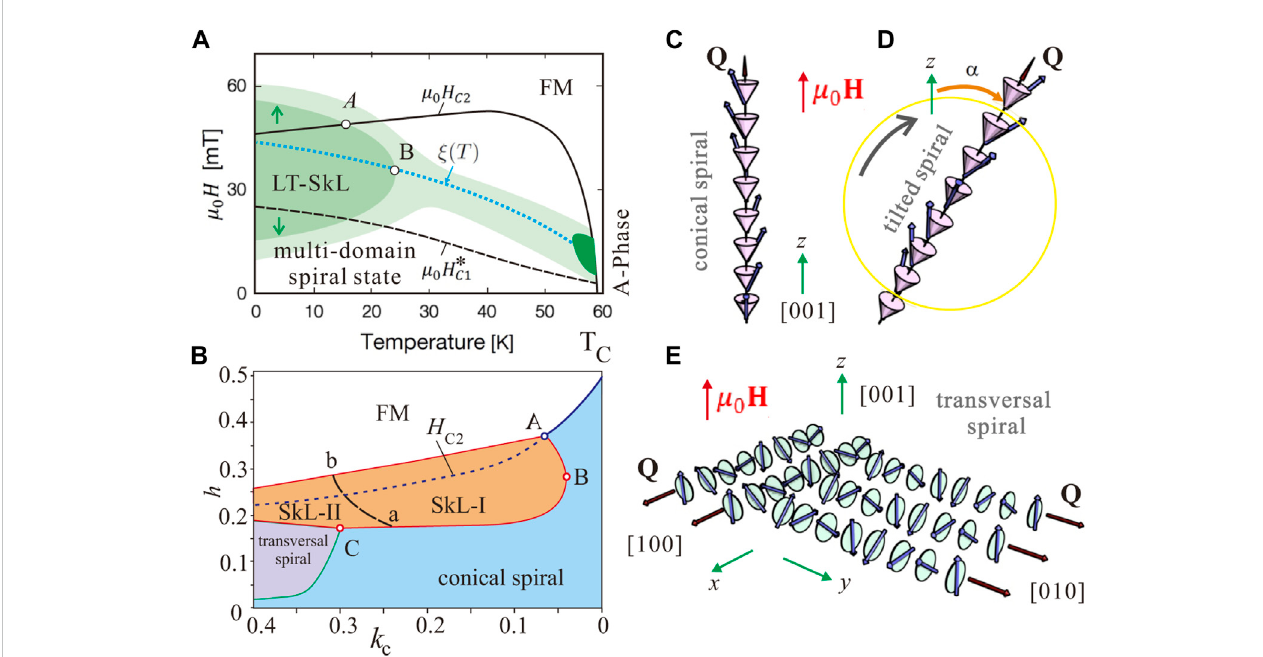
FIGURE 1 (coloronline) (A) Sketchoftheexperimentalphasediagramindicating [3,5]theextentandintensityofskyrmionicscatteringafterzero fi eldcooling(ZFC) forH (cid:1) k i (cid:1) [001].Thesamplewasbroughttoeachselectedtargettemperatureaftercoolingitthrough T C ≈ 59 Kunderzeromagnetic fi eld(i.e.undertheresidual magnetic fi eld of the cryomagnet). Then, the measurements were performed upon increasing and decreasing the magnetic fi eld and indicated hysteresis of LT-SkL formation [3, 6], i.e., skyrmionic scattering concentrates around the H C 2 line when the magnetic fi eld increases from zero to above H C 2 , and around the H C 1 line when the magnetic fi eld subsequently decreases from above H C 2 to zero. Here, however, we superimpose both SkL stability regions, but indicate the described hysteresis by the green arrows. Deep dark green stands for the high-temperature A-phase; dark green — for the low-temperature SkL; and light green — for the weak scattering that surrounds both the LT and HT skyrmion pockets and connects them along the line ξ ( T ). Genuine experimental phase diagrams can be found in Refs. [3, 6], and [7]. (B) The theoretical phase diagram for k c > 0 and b ea = 0 for h (cid:1) [001]. The regions of the thermodynamical stability are colored orange (skyrmions), blue (cones), and pink (transversal spirals). Both phase diagrams containthe following characteristic points: point A is an intersection point between the curve H C 2 and an upper boundary of a LT-SkL pocket, which demarcates two temperature regimes and thus nucleation mechanismsof aSKL; pointBistheoutermostpointoftheLT-SkL pocket,whichallows thedirectascription ofthetemperaturefrom theexperimental